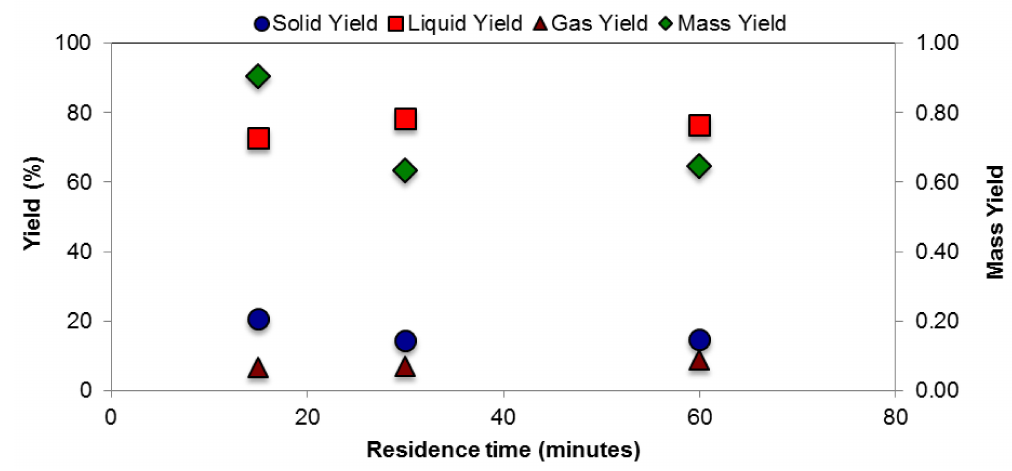
Figure 2. Effect of residence time on the products